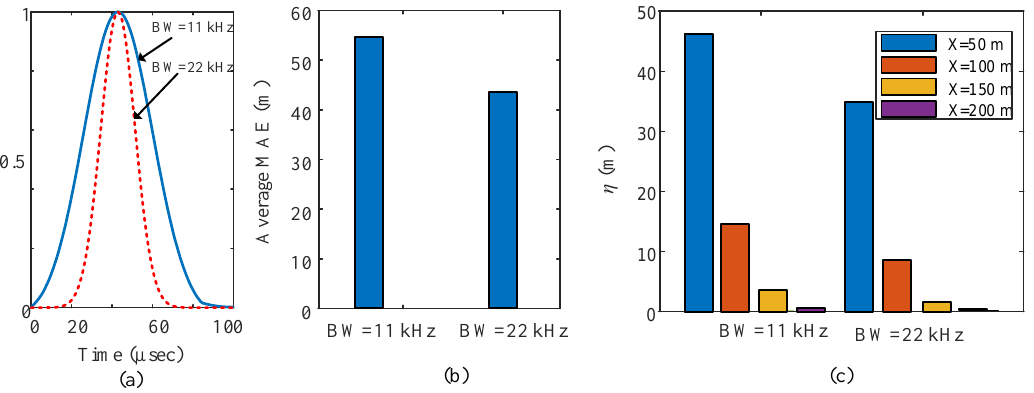
Figure 6. Sensing signal bandwidth effect on the system performance: ( a ) Gaussian sensing signals, ( b ) average MAE, and ( c ) value of η with prediction error > X m.